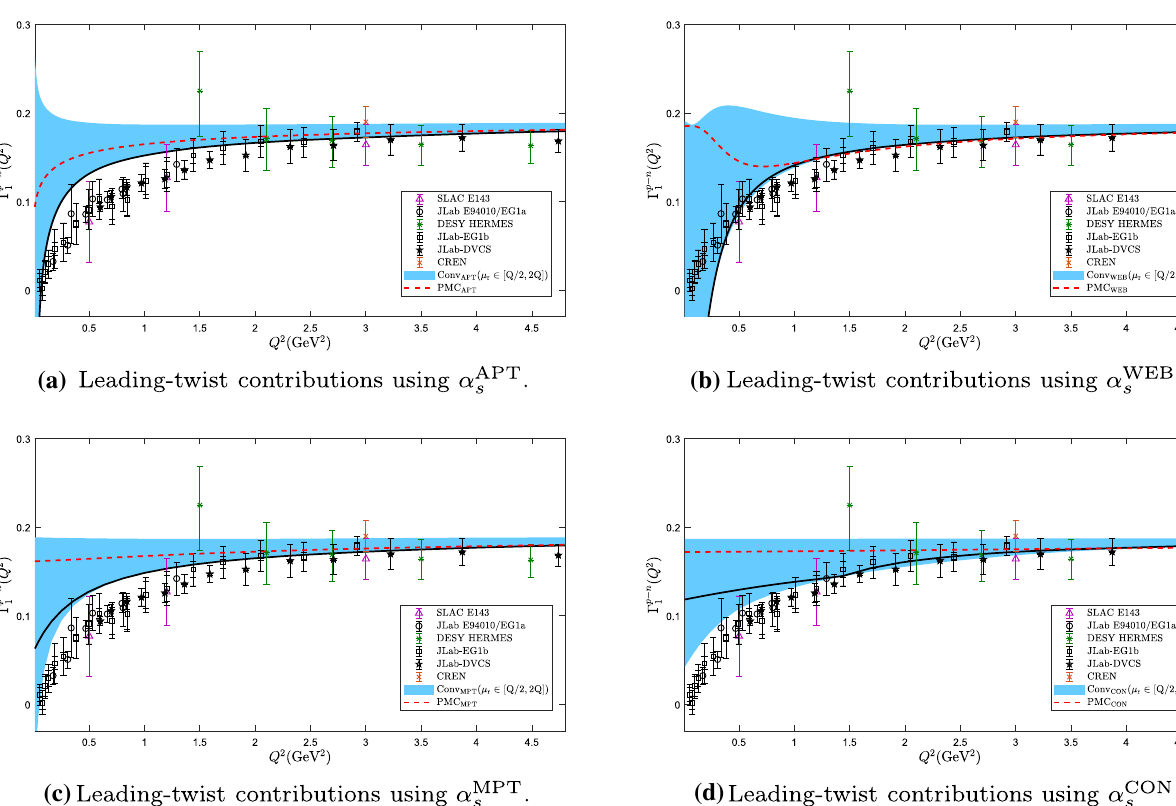
with μ r = Q andtheshadedbandshowsitsscaleuncertaintybyvarying μ ∈ [ Q / 2 , 2 Q ] . The dot-dashed line is the prediction (cid:3) p − n s r N 4 LOforPMCscale-settingapproach, whichisfreeofrenormalization scale dependence